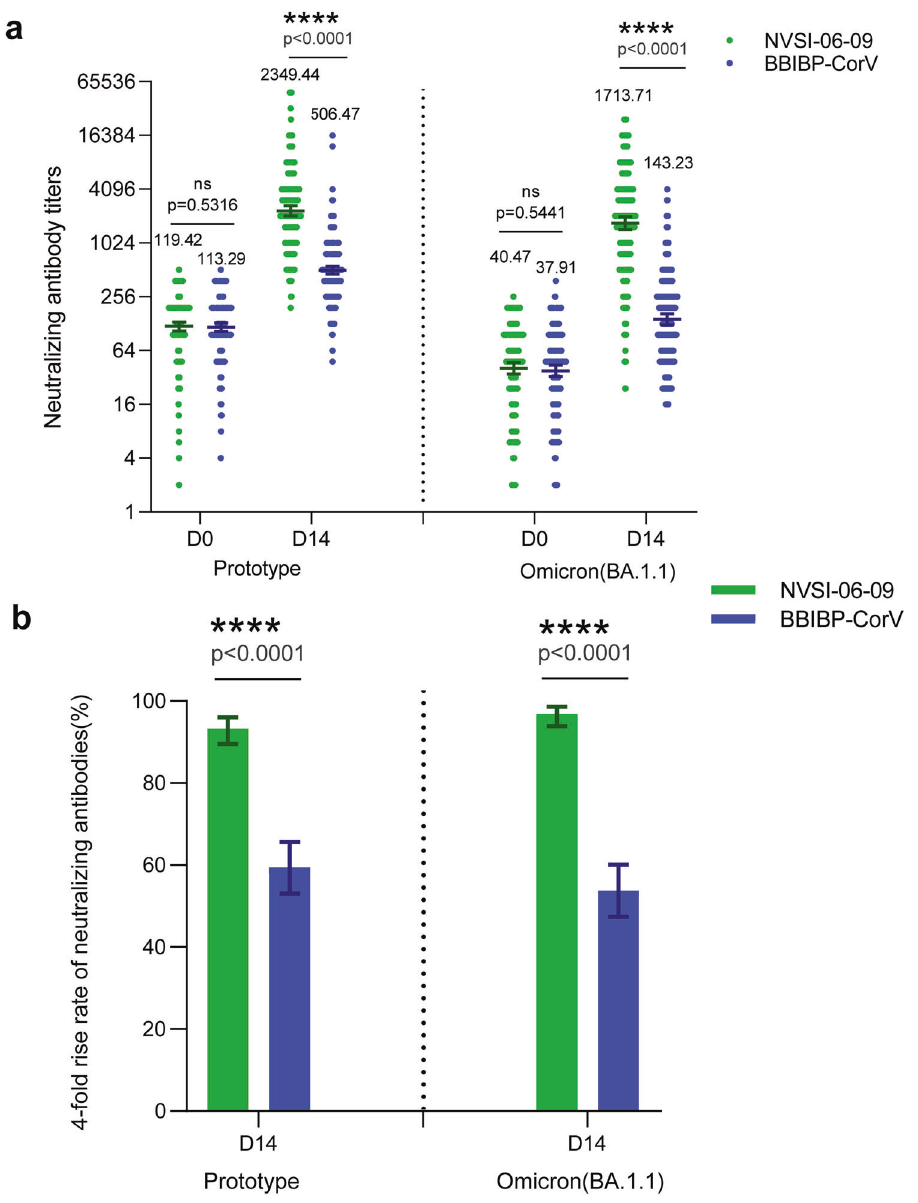
Fig. 3 The live-virus neutralizing antibody titers, along with the corresponding fourfold rise rate, against prototype SARS-CoV-2 strain and Omicron BA.1.1 variant induced by the booster vaccination of NVSI-06-09, compared with those boosted with BBIBP-CorV. a The anti- prototype and anti-Omicron BA.1.1 neutralizing antibody titers at baseline and on day 14 after booster vaccination. Data are presented as GMTs and 95% CIs. b The corresponding fourfold rise rate of neutralizing antibodies from baseline and 95% CIs on day 14 after booster. ****: p < 0.0001, ns not signi fi